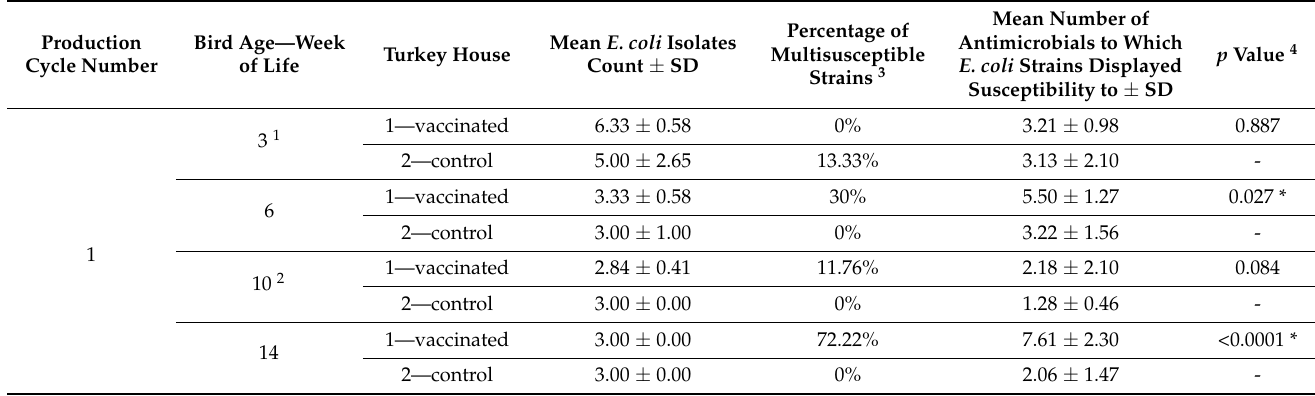
Table 5. Summarized results of microbiological studies from experiment